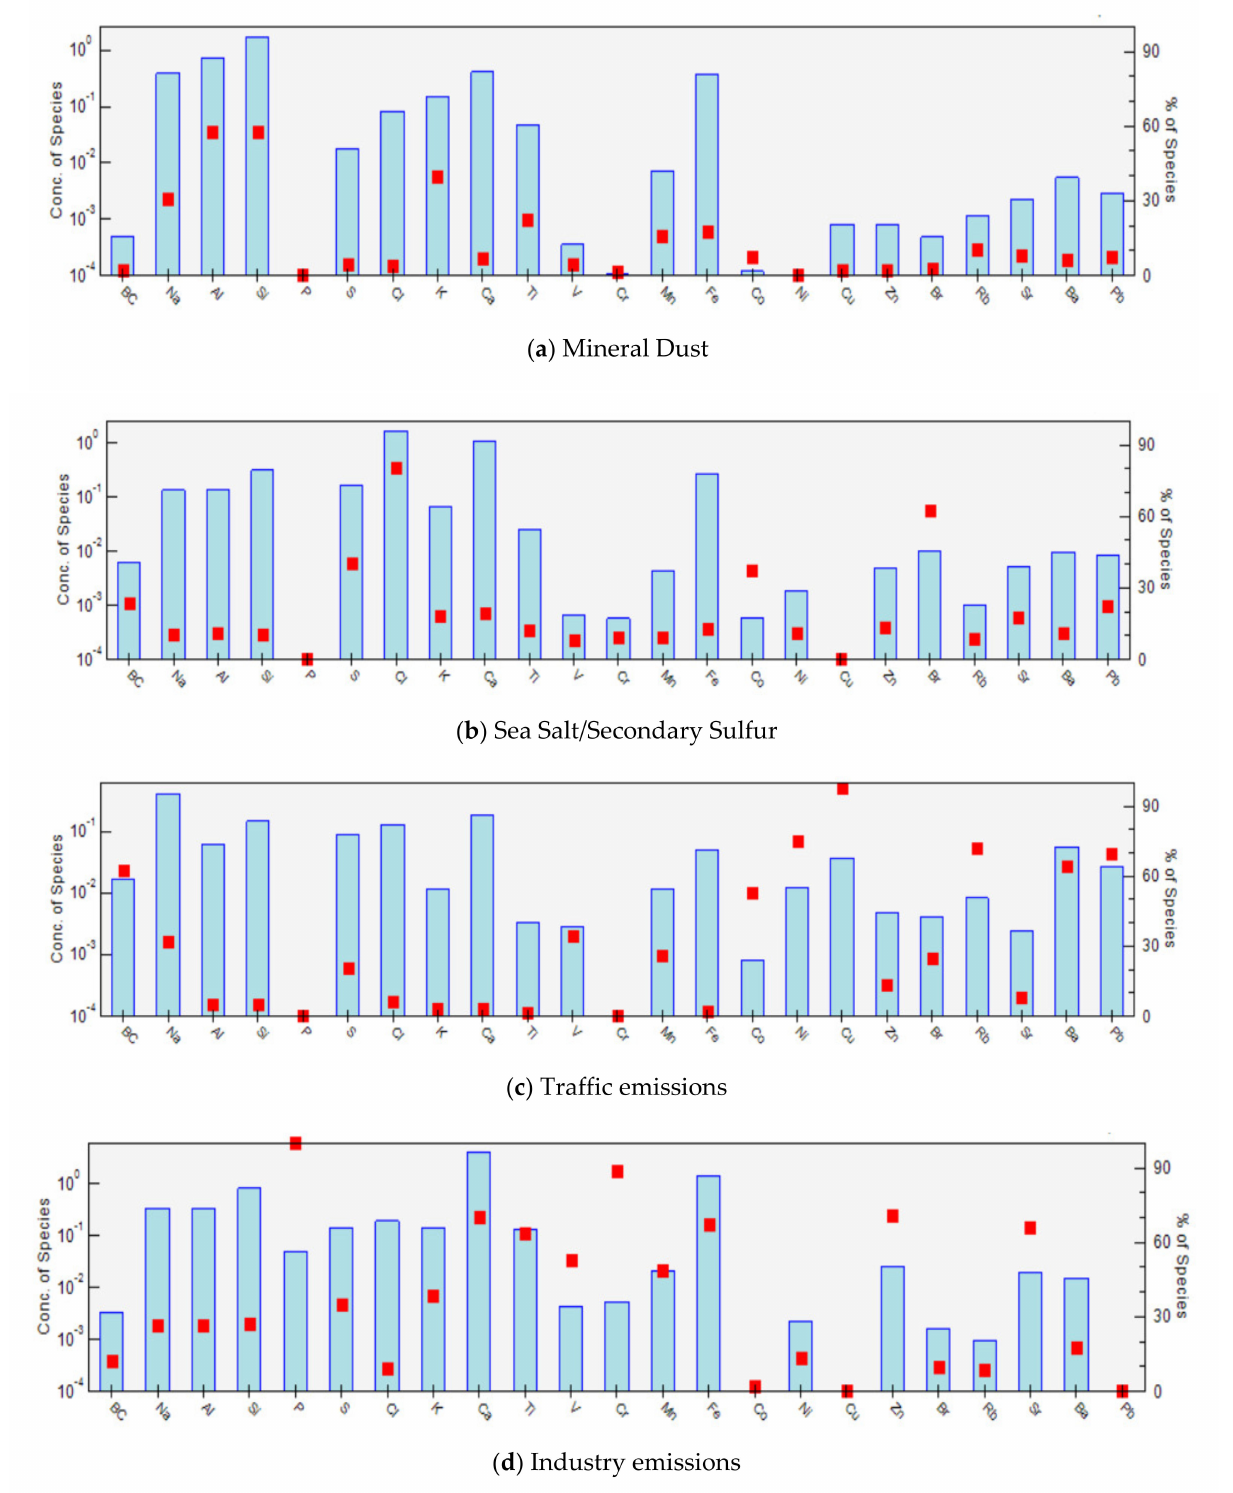
Figure 4. PM sources profiles. The bars represent the normalized concentration of the species in the profile, and the squares show the contribution of the source to the average species concentration with ( a ) Mineral Dust, ( b ) Sea Salt/Secondary Sulfur, ( c )Traffic and ( d ) Industry